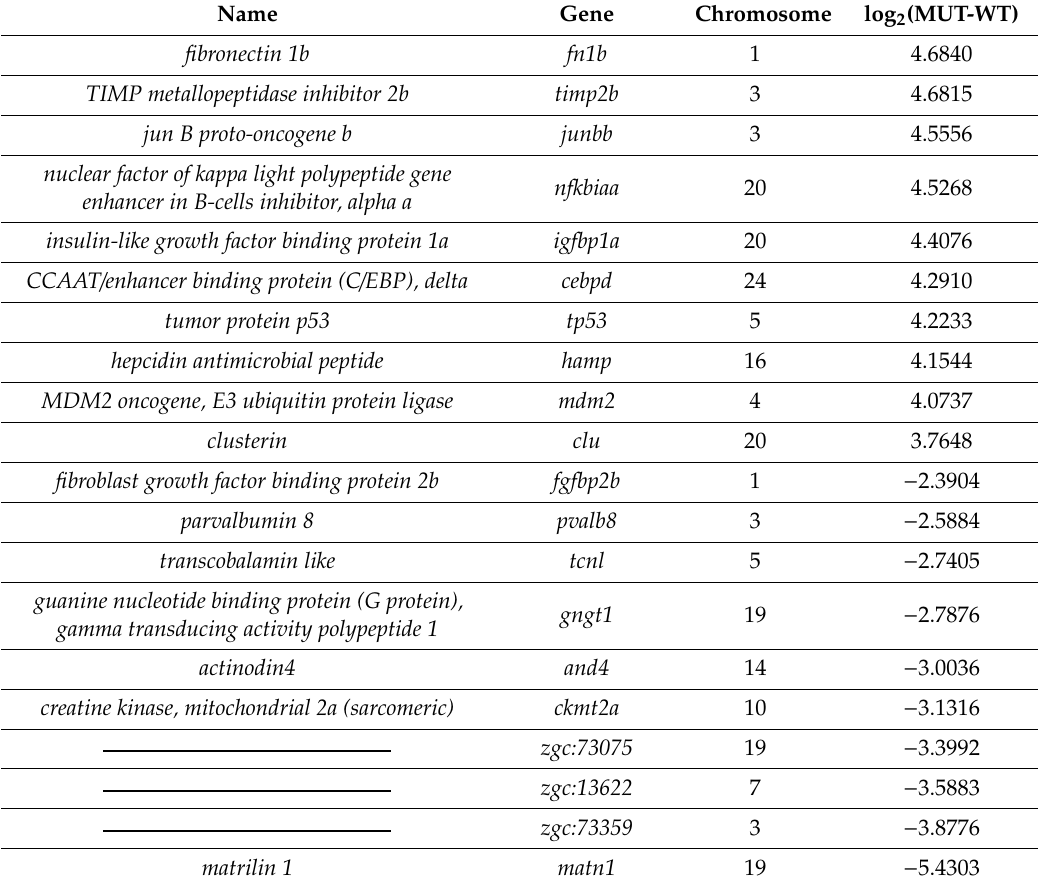
Table 5. Top 10 upregulated and downregulated genes from RNA-Seq with FPKM > 0.1 in both samples.